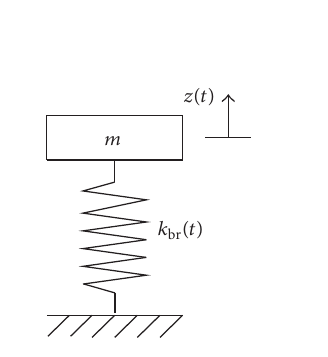
Figure 2: Vibration model of a cantilever beam with a breathing oblique